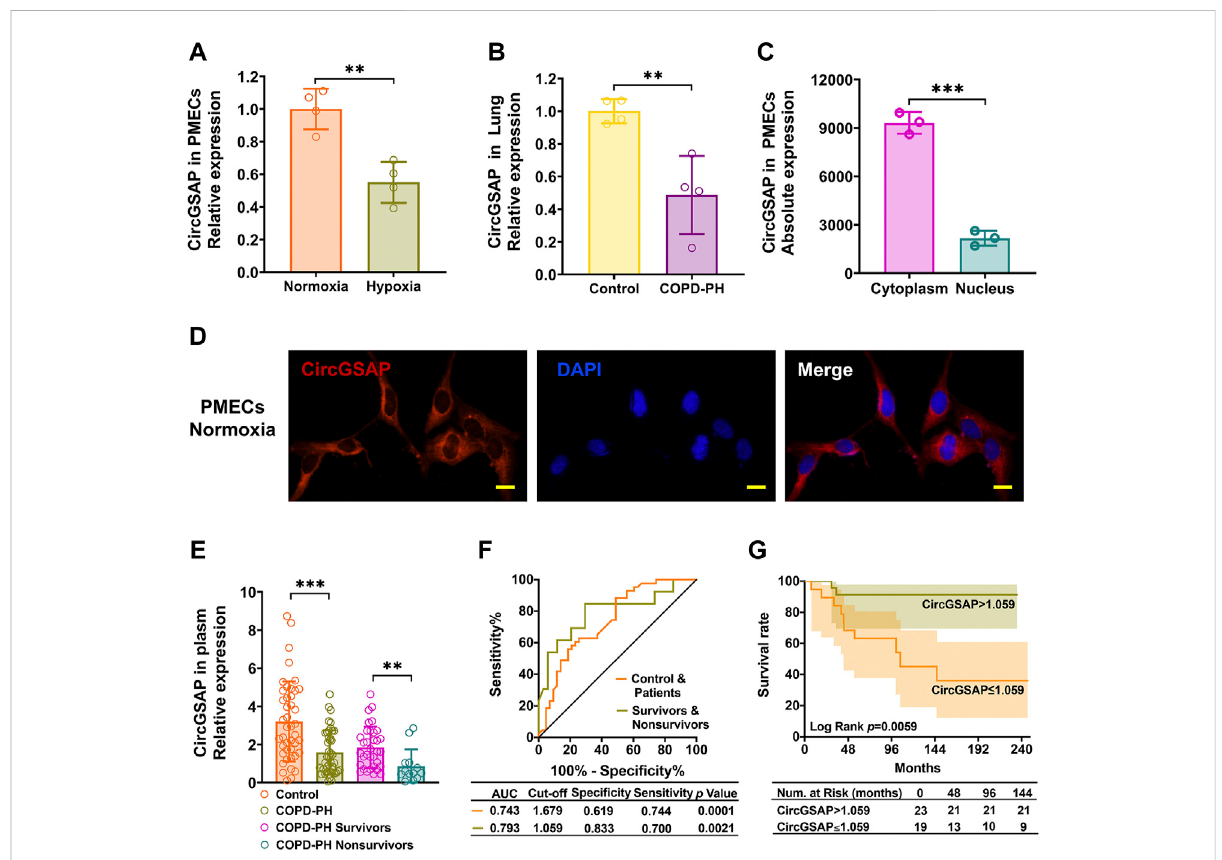
FIGURE 1 Theexpression ofcircGSAPinhuman PMECs, lung tissuesandplasma. (A) Quantitativereversetranscription PCR(qRT-PCR)for theabundance of circGSAP in normoxia and hypoxia of PMECs ( n = 4). (B) Expression levels of circGSAP in lung tissues of COPD-PH were determined by qRT-PCR ( n = 4). (C) Levels ofcircGSAP in thecytoplasmicand nuclear fractions of PMECs ( n = 3). (D) FISH was used to determine thedistributionof circGSAP inPMECs. (E) Expression levels ofcircGSAP inplasma samples ofCOPD-PH,survivors and nonsurvivorsweredetermined byqRT-PCR. (F) ROC curvesofcircGSAPinpatientswithCOPD-PH,survivorsandnonsurvivorswithCOPD-PH. (G) Kaplan-Meiersurvivalanalysisformortalitystrati fi edby the cutoff values of circGSAP in COPD-PH. All data are presented as the mean ± SEM. (scale bar, 10 μ m). * p < 0.05; ** p < 0.01; *** p <